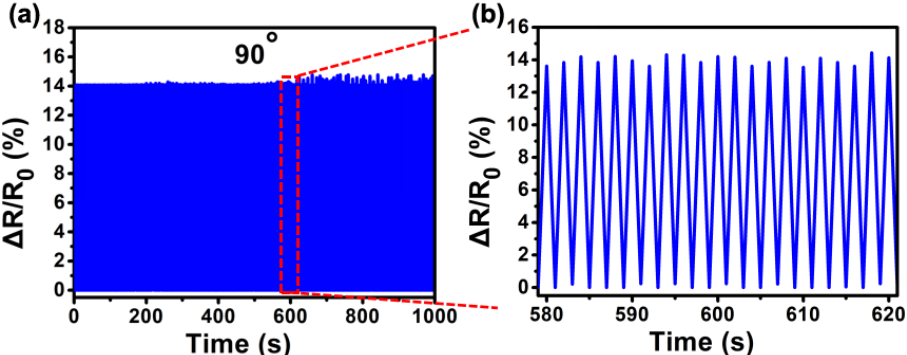
Figure 6. ( a ) The sensor is tested for 90° bending for 480 cycles. ( b ) The 21 cyclic tests extracted from the red region in ( a ).